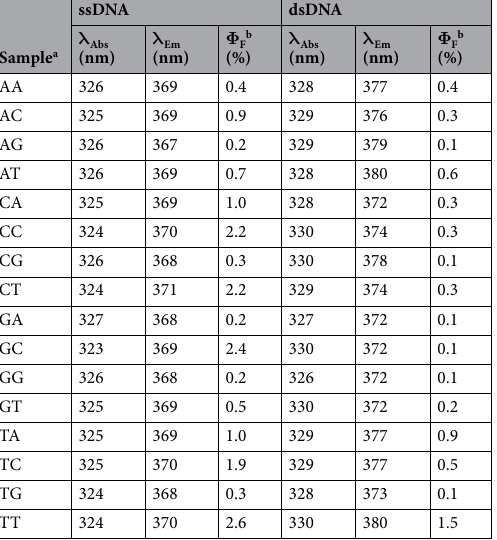
Table 3. Photophysical properties of bT in the 16 modified oligonucleotides in single- (ssDNA) and double- stranded (dsDNA) environment. a For sequences, see Table 2. Measurements were performed at